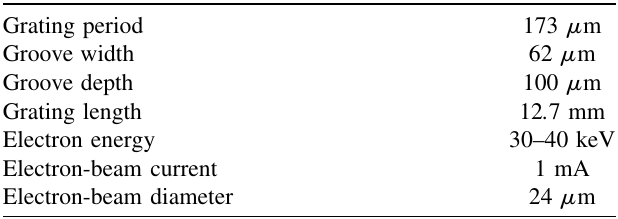
TABLE I. Parameters of the Dartmouth experiment.